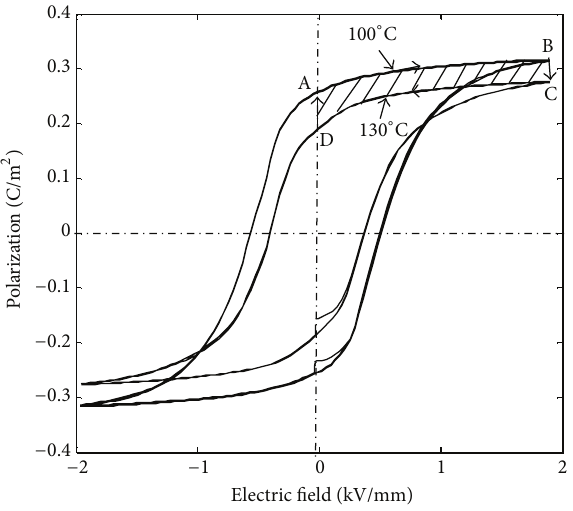
Figure 2: Polarization-electric field characteristics of PZT-4.5PT at two different temperatures of 100 and 130 ∘ C.